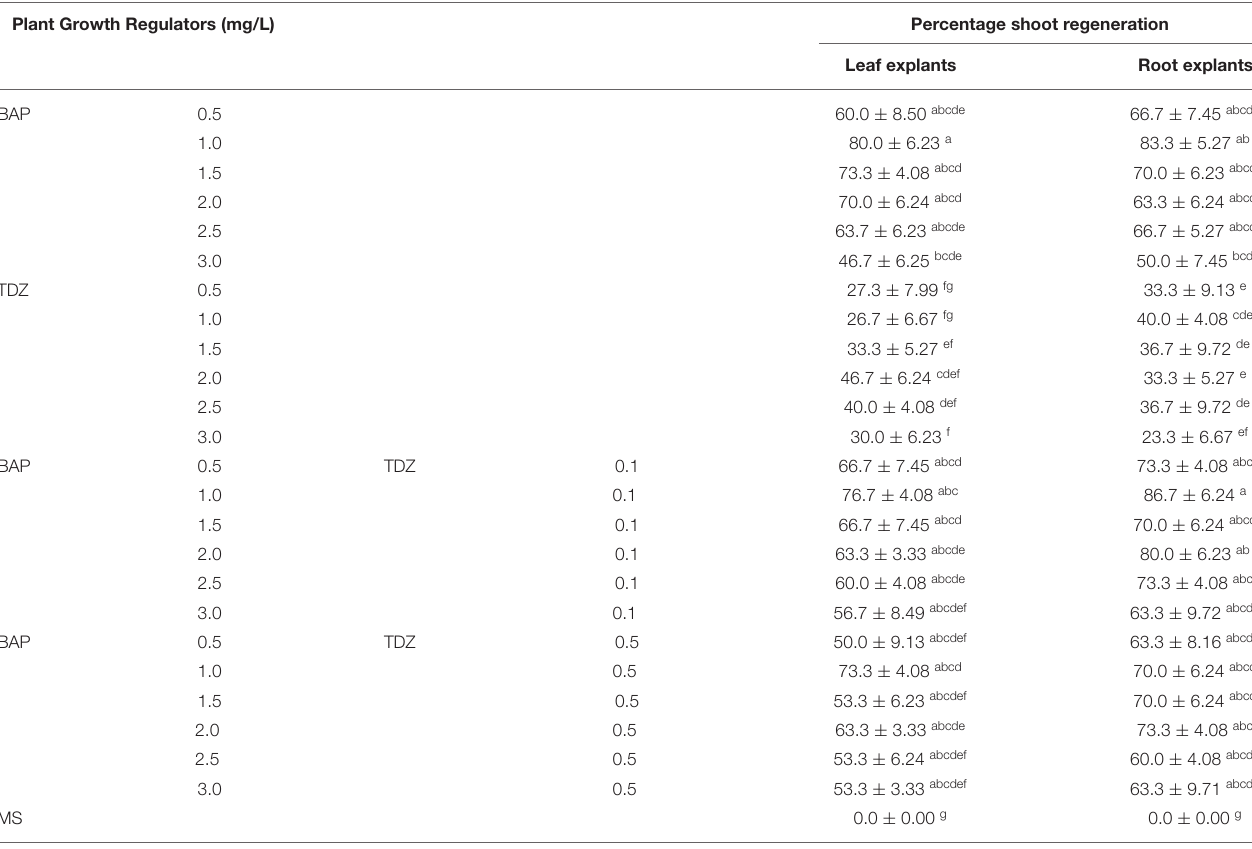
TABLE 2 | Percentage shoot regeneration from calli obtained from leaf and root explants of A. africana . Plant Growth Regulators (mg/L)